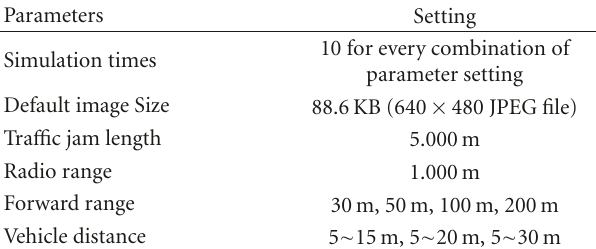
Table 2: The parameter setting of network transmission simula-